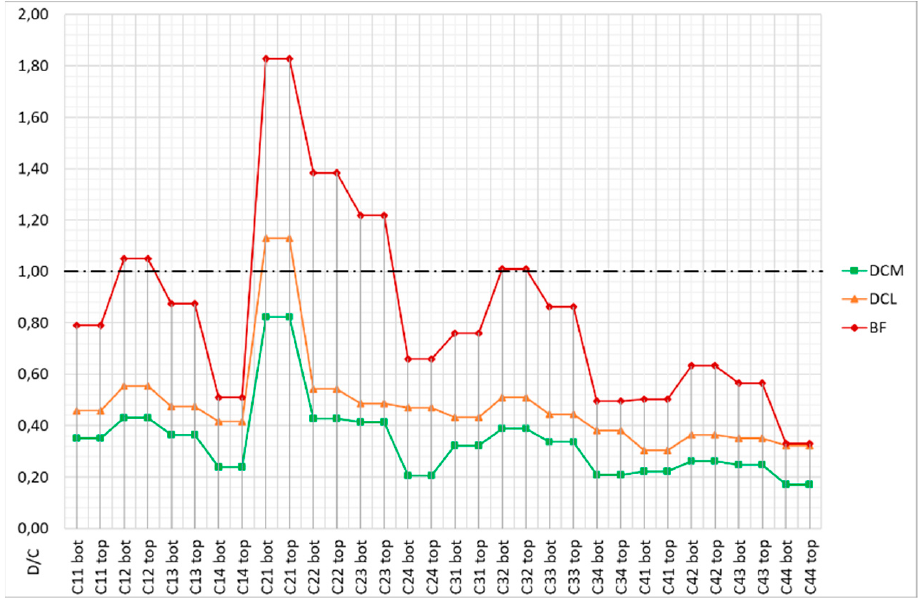
Figure 6. NC shear force 𝐷 𝐶⁄ ratios on columns ( q- factor approach results).